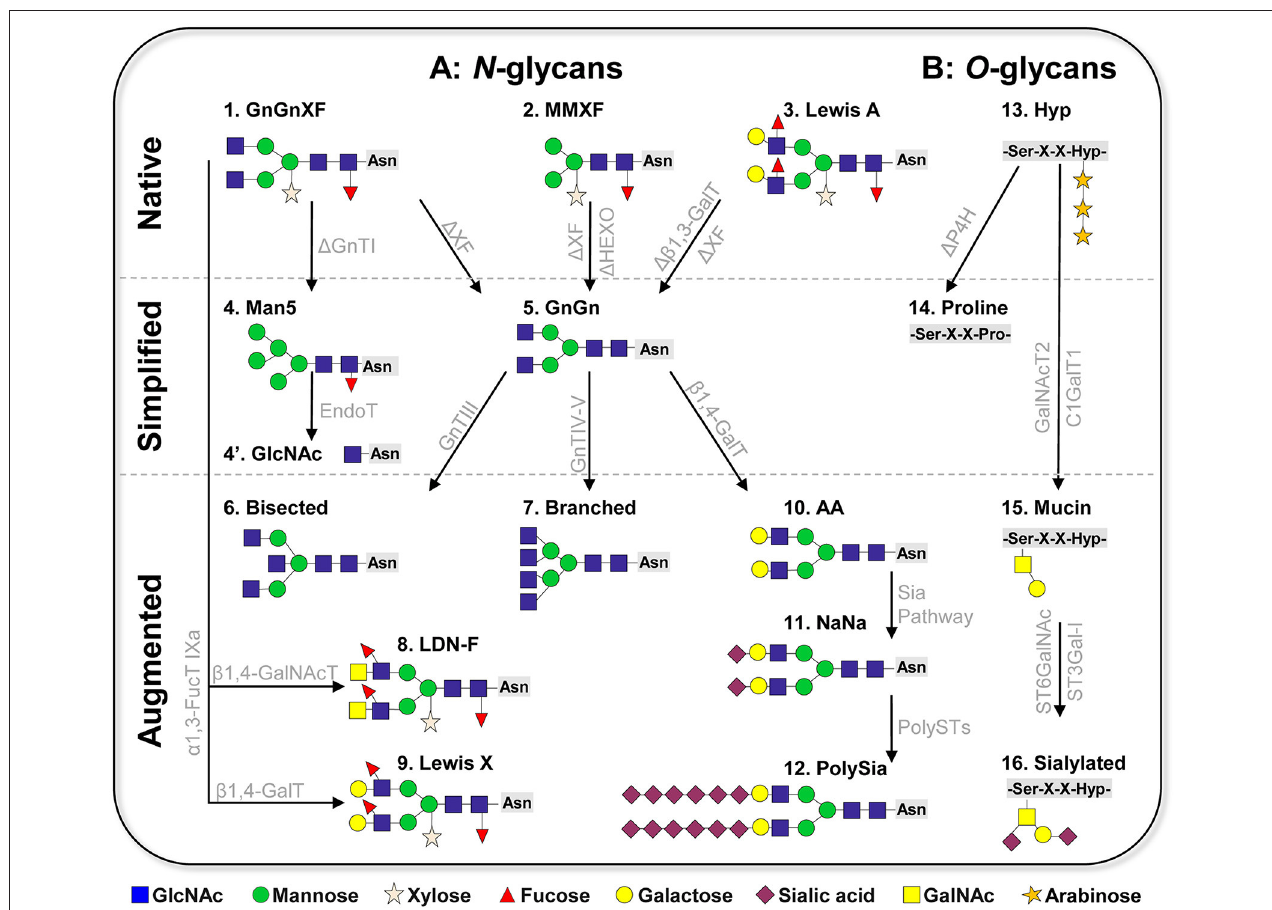
FIGURE 1 | Schematic presentation of plant-based glycan engineering (A) N- linked glycans. Native: The three major complex glycoforms frequently detected in wild-type plants are 1: GnGnXF, 2: MMXF paucimannosidic structures, and 3: Lewis A structures. Simplified: Glycan simplification and homogeneity by ′ knockout/down approaches (creating the “chassis”). 4: Man5 structure generated by GnTI knockout/down; 4 : single GlcNAc (GlycoDelete); 5: GnGn (common eukaryotic core). Augmentation of plant glycans by stable/transient overexpression of foreign glycosylation enzymes. 6: bisected (GnGnbi) structure; 7: branched ([GnGn][GnGn]) structure; 8: helminth LDN-F structure; 9: Lewis X structure; 10: AA ( β 1,4-galactosylated structures); 11: NaNa ( α 2,6-sialylated glycoforms); 12: polysialylated glycans. (B) O -linked glycans. 13: common native O -glycans (hydroxyproline, Hyp, decorated with arabinose residues); 14: PH4 knockout to prevent conversion of prolines to Hyp; 15: generation of mucin type O -glycans by the overexpression of human polypeptide GalNAc-transferase 2 (GalNAcT2) and Drosophila melanogaster core β 1,3-galactosyltransferase (C1GalT1); 16: sialylation of O -glycans by overexpression of α 2,6- and α 2,3-sialyltransferases (ST6GalNAc, ST3Gal-I). 1 XF: knockout/down of α 1,3-fucosyltransferase and core β 1,2-xylosyltransferase; 1 HEXO: knockout of β - N -acetylhexosaminidases HEXO1 and HEXO3; Sia Pathway: recombinant expression of the sialic acid pathway as described by Castilho et al. (2010); PolyST: α 2,8 polysialyltransferase II, IV; P4H: prolyl-4-hydroxylase. Glycan nomenclature: Consortium of functional